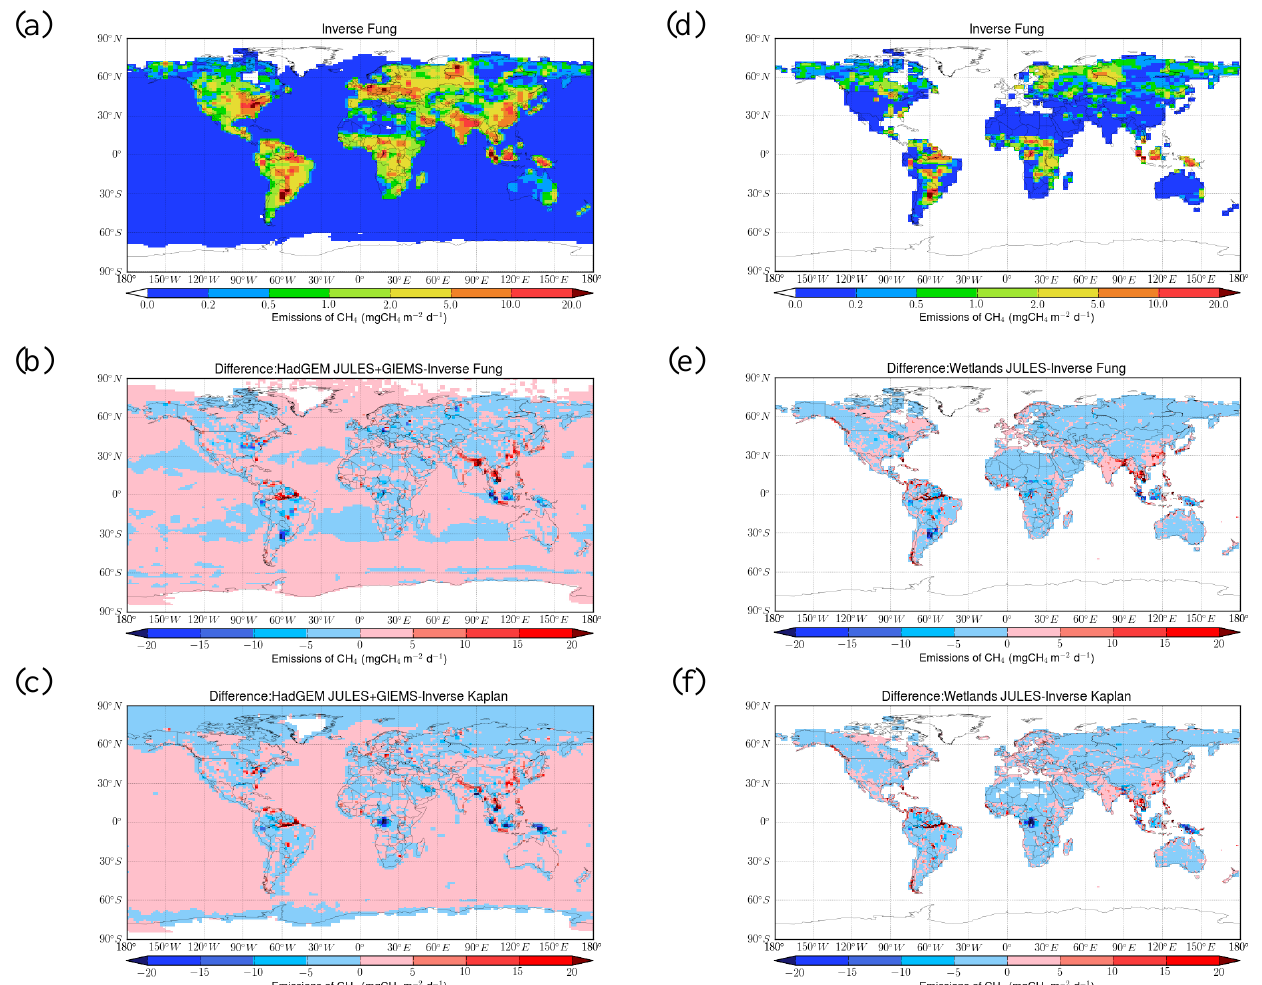
Figure 13. Annual methane emissions for 2000 from all sources (left-hand panels) and wetlands (right-hand panels). The upper panels (a, d) show the emission maps from the inverse modelling of Bousquet et al. (2011) using the data set of Fung et al. (1991) for the prior wetland emissions. Panels ( b ) and ( e ) show difference maps between the emission estimates shown in Panels ( a ) and ( d ) and the corresponding inventories using the JULES-GIEMS wetland emission inventory. Panels ( c ) and ( f ) are the same as Panels ( b ) and ( e ) but replacing the prior wetland emissions with those of Kaplan (as described in Bergamaschi et al.,